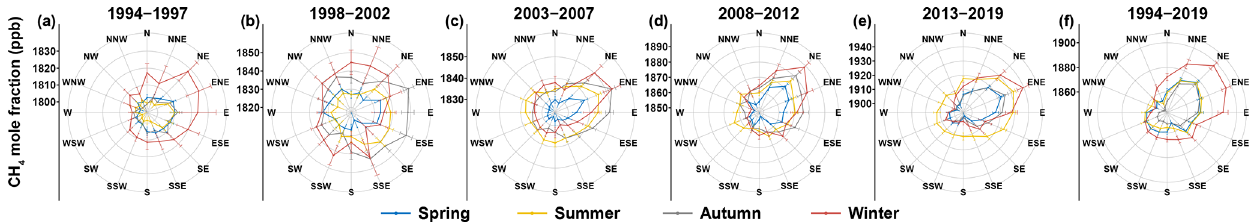
Figure 4. The wind rose distribution of the average CH 4 mole fractions from 16 horizontal wind directions over different periods during 1994–2019 at the WLG station. The different colors represent the CH 4 data in different seasons. Error bars in all directions indicate 95% confidence